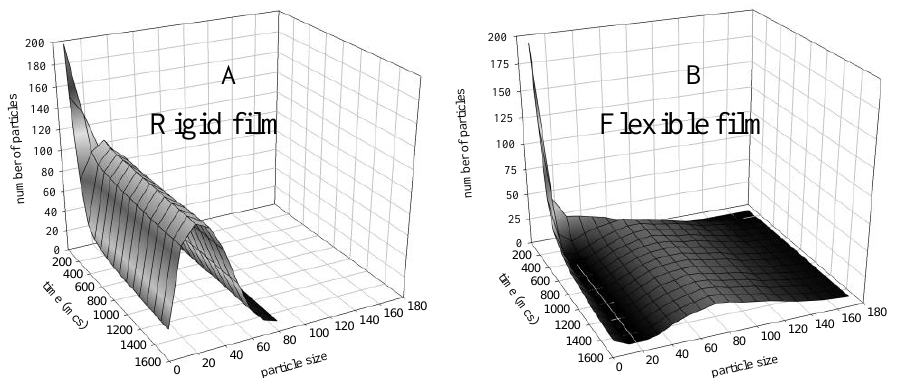
Figure 1. Time evolution of the number of droplets containing particles using different flexibility. Synthesis conditions: concentration  c chemical reaction rate v = 1, critical nucleus size n* = 1, no restriction by droplet